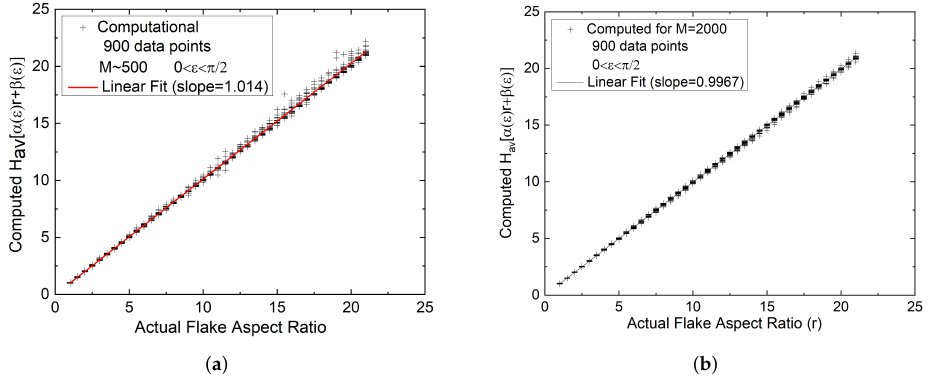
Figure 9. Computational results for H av , plotted as suggested by Equation (10). Each data point was obtained from one sample having M flake intersections with flakes of aspect ratio r and random orientation in the interval [– (cid:101) , + (cid:101) ], 0 < (cid:101) < π /2. While the scatter around the line of unit slope is slightly higher at larger values of r and for a smaller sample size M , the best fit lines through all data have slopes that are very close to 1.